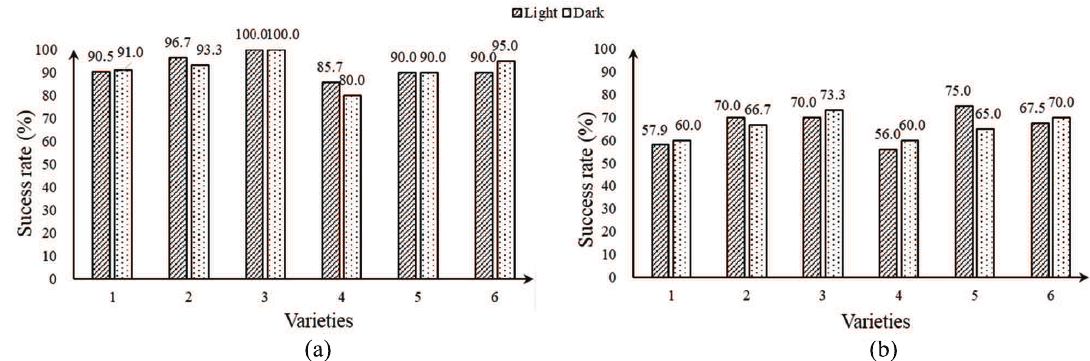
Figure 19. Recognition results of six types of citrus: ( a ) little occlusion and adhesion; ( b ) serious occlusion and adhesion. 1. Jiangxinzhou tangerine; 2. Gannan navel orange; 3. Egyptian orange; 4. Yunnan sugar orange; 5. Sichuan ugly orange; 6. Yongchun ponkan. Comments: Little occlusion and adhesion mean that the fruit can be detected at > 50% of the surface and few parts of the fruit and leaf have adhesion. Serious occlusion and adhesion mean that the fruit can be detected at ≤ 50% of the surface and the main body parts of the fruit and leaf have obvious